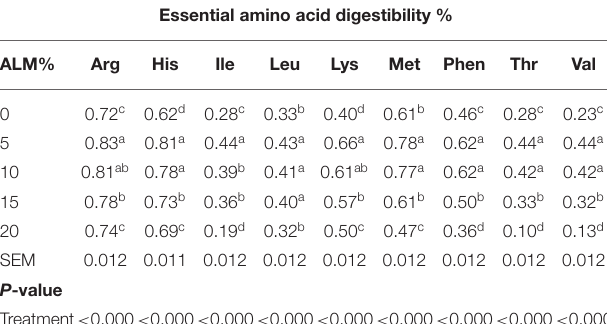
TABLE 5 | Effect of amaranth leaf meal (ALM) inclusion on nutrient digestibility (%) of Ross 308 broiler chickens. Nutrient digestibility